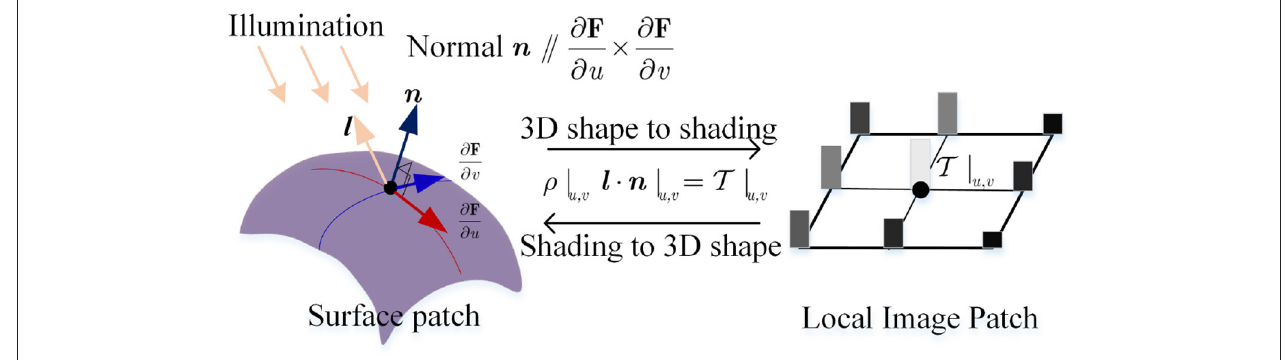
FIGURE 3 | The consistency mapping equivalence between embedding F and the image